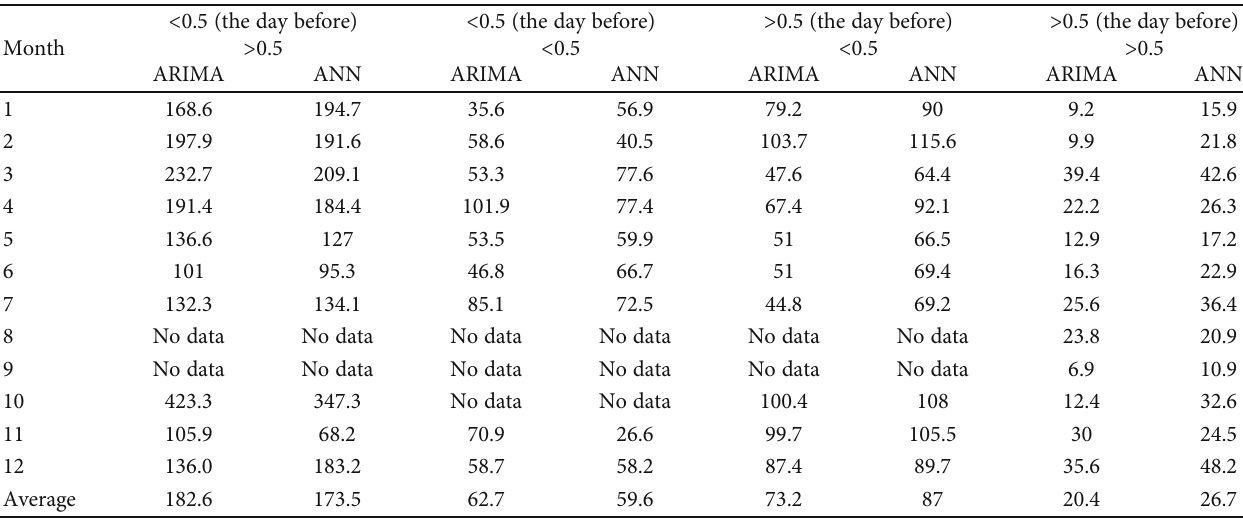
Table 2: rRMSE values in the case of the four quanti fi ed situations of the V period of 10